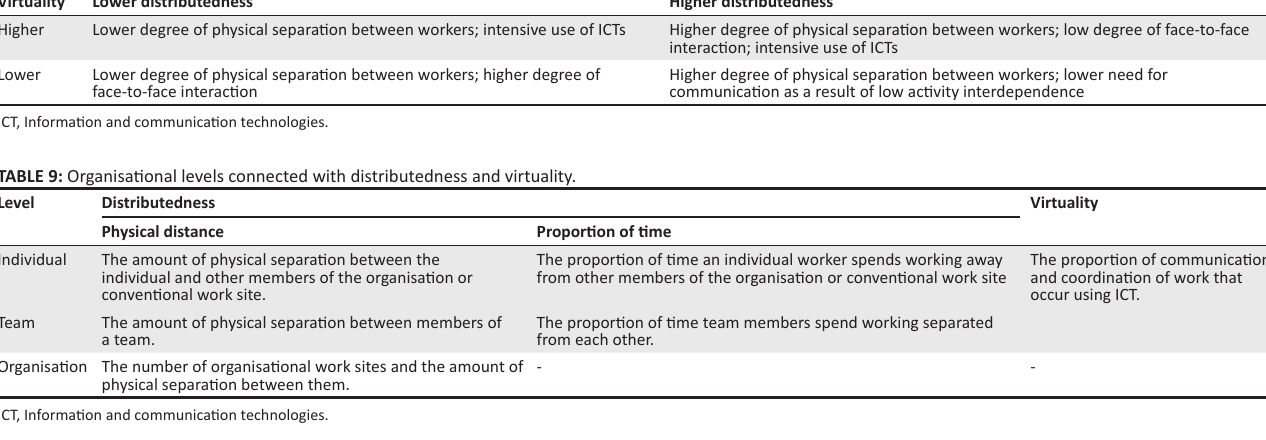
TABLE 8: Combining distributedness and virtuality to describe work practices. Virtuality